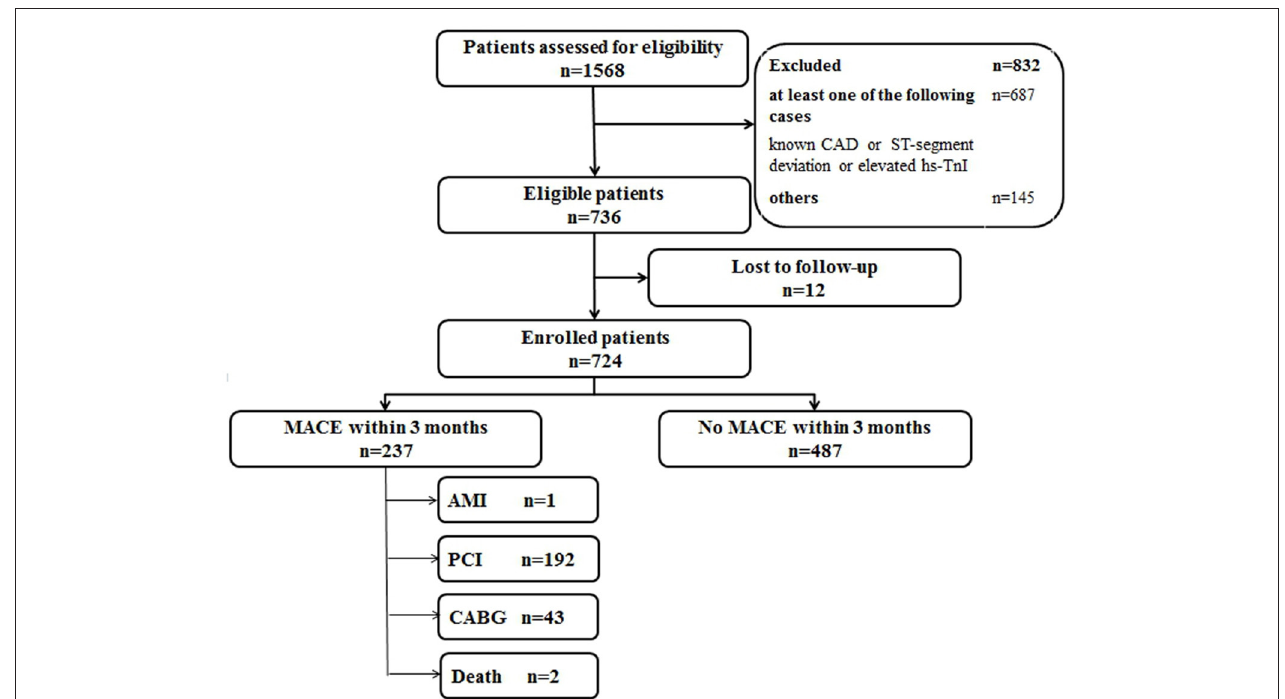
FIGURE 1 | Flow diagram of participants in the derivation cohort study. CAD, coronary artery disease; hs-TnI, high-sensitivity Troponin I; MACE, major adverse coronary events; AMI, acute myocardial infarction; PCI, percutaneous coronary intervention; CABG, coronary artery bypass graft.